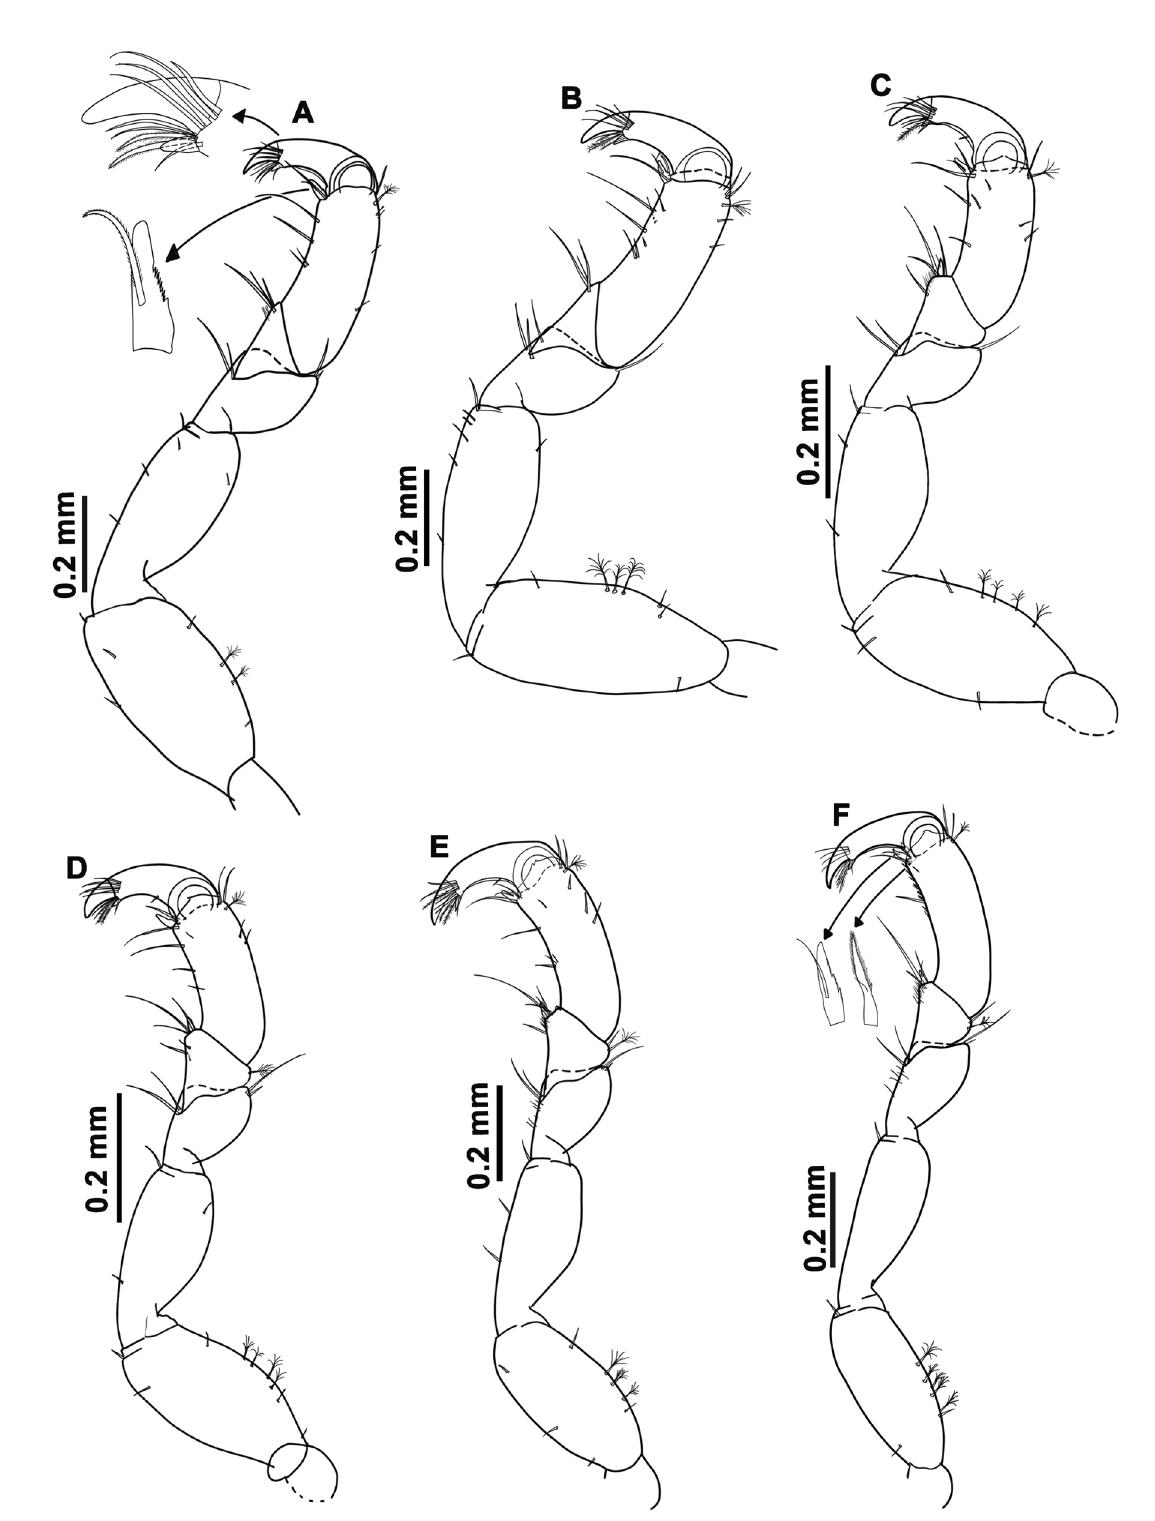
Fig. 9. Mesanthura antenniformis sp. nov., holotype, ♀ (ovigerous), 8 mm, Oaxaca, Puerto Ángel, Estacahuite Beach (UMAR-PERA 542). A . Pereopod 2 and detail of dactylus. B . Pereopod 3. C . Pereopod 4. D . Pereopod 5. E . Pereopod 6. F . Pereopod 7 and detail of the sensory